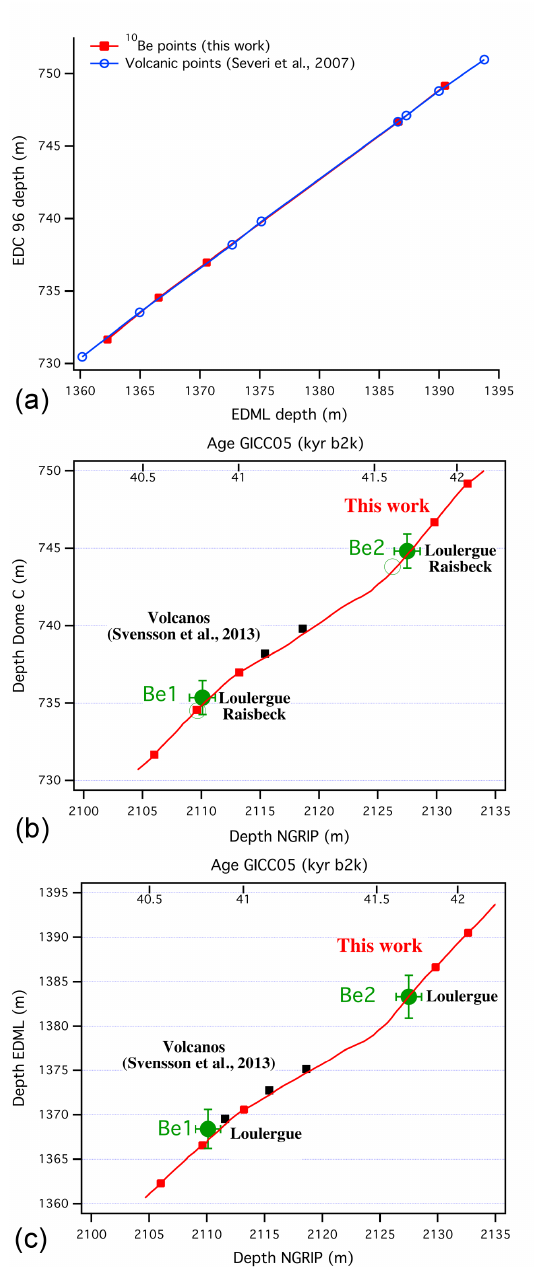
Figure 3. Comparison of the different tie points between (a) EDC and EDML, (b) NGRIP and Dome C and (c) NGRIP and EDML, as derived from 10 Be from this work (red squares and line), from Loulergue et al. (2007) (green full circles) from Rais- beck et al. (2007) (green empty circles) with additional volcanic EDML/EDC tie points (open blue circles from Severi et al., 2007) and proposed bipolar volcanic points (full black squares from Svensson et al., 2013). We have indicated the uncertainty for the tie points used in Loulergue et al. (2007). For the new 10 Be and volcanic tie points, the uncertainties are smaller than their